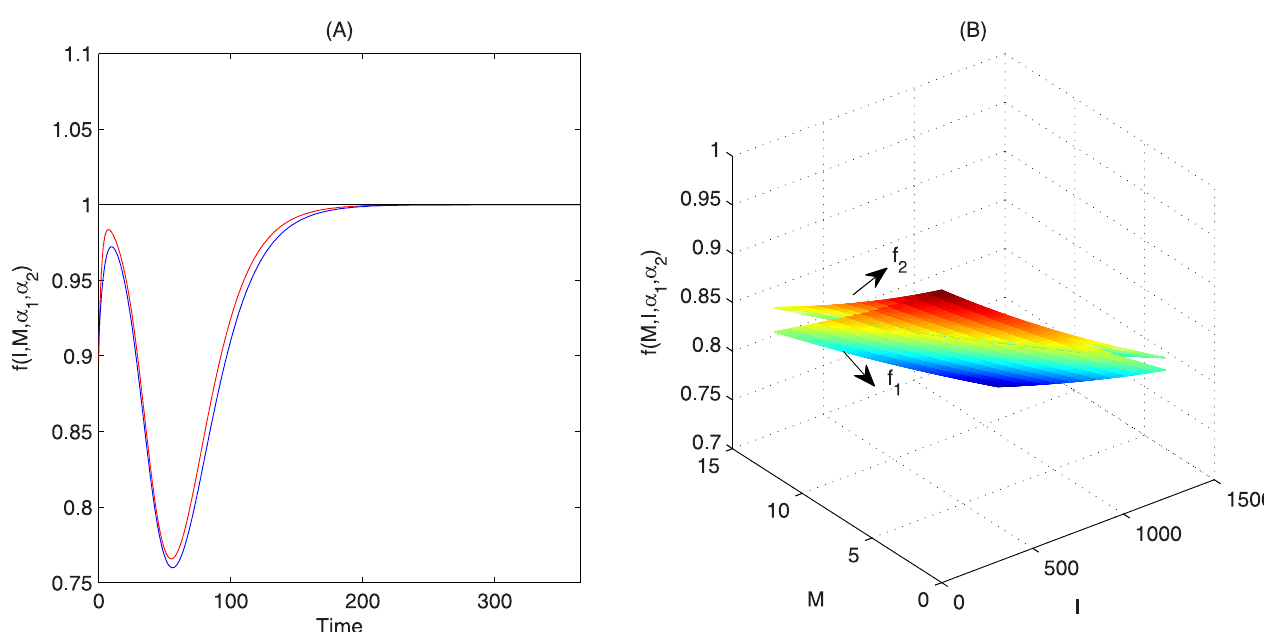
Fig 4. Comparison of media functions. (A) Comparison of media functions in system (1) varying with time, black curve, red curve and blue curve represent , respectively. (B) Comparison of f 1 and f 2 when parameters α 1 and α 2 are fixed as values estimated by using Least Square f 0 = 1, f 1 = e − α 1 I − α 2 M , f 2 ¼ 1 1 þ a 1 I þ a 2 M Method and I , M vary.